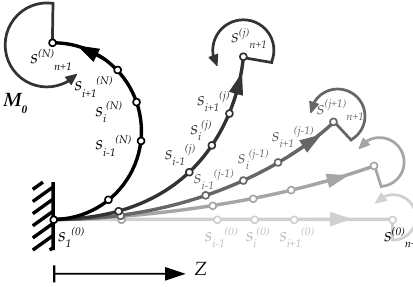
Figure 2. Discretization of the beam axis: Location of nodes at different